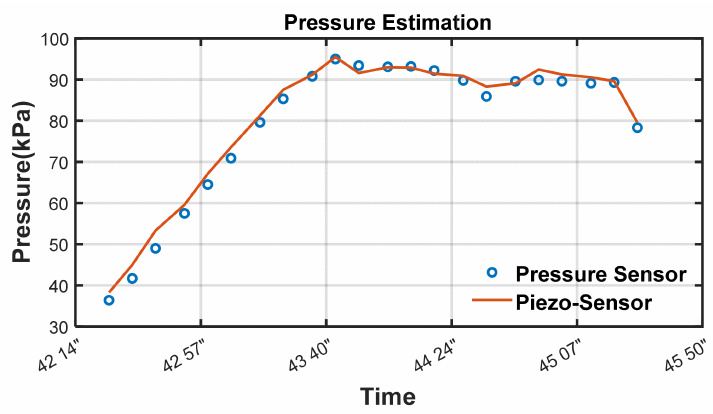
Figure 15. Result of pressure estimation using EMI in the damaged case (test